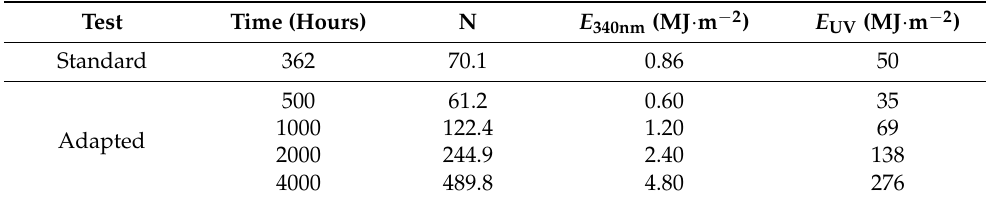
Table 3. The number of weathering cycles and total radiant exposure for the different labora- tory weathering tests. (Notation: N—number of cycles; E 340nm —total radiant exposure at 340 nm; E UV —total UV radiant